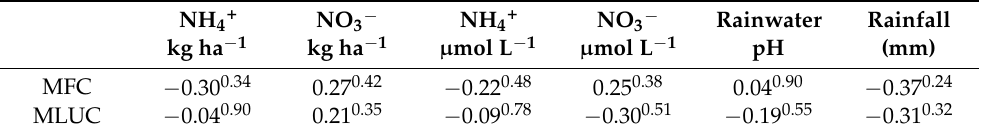
Table 2. Pearson correlation coefficients between the amount of fires that winds arriving at our sampling site passed over in the month before rainfall (MFC), the amount of oil palm cultivated area that winds arriving at our sampling site passed over in the month before rainfall (MLUC) and different monthly rainfall characteristics (total NH 4+ -N and NO 3 − -N deposition, NH 4+ and NO 3 − mean concentration in rainfall, mean rainwater pH and rainfall amount). Rainfall samples were collected throughout one year at the Forest Research Centre, Sepilok, Sabah, Malaysia. The p - values (adjusted using the Benjamini–Hochberg false discovery rate are noted in superscript and were all non-significant. Rainwater Rainfall NH 4+ NO 3 − NH 4+ NO 3 − µ mol L − 1 µ mol L − 1 pH (mm) kg ha − 1 kg ha − 1 MFC − 0.30 0.34 0.27 0.42 − 0.22 0.48 0.25 0.38 0.04 0.90 − 0.37 0.24 MLUC − 0.04 0.90 0.21 0.35 − 0.09 0.78 − 0.30 0.51 − 0.19 0.55 − 0.31